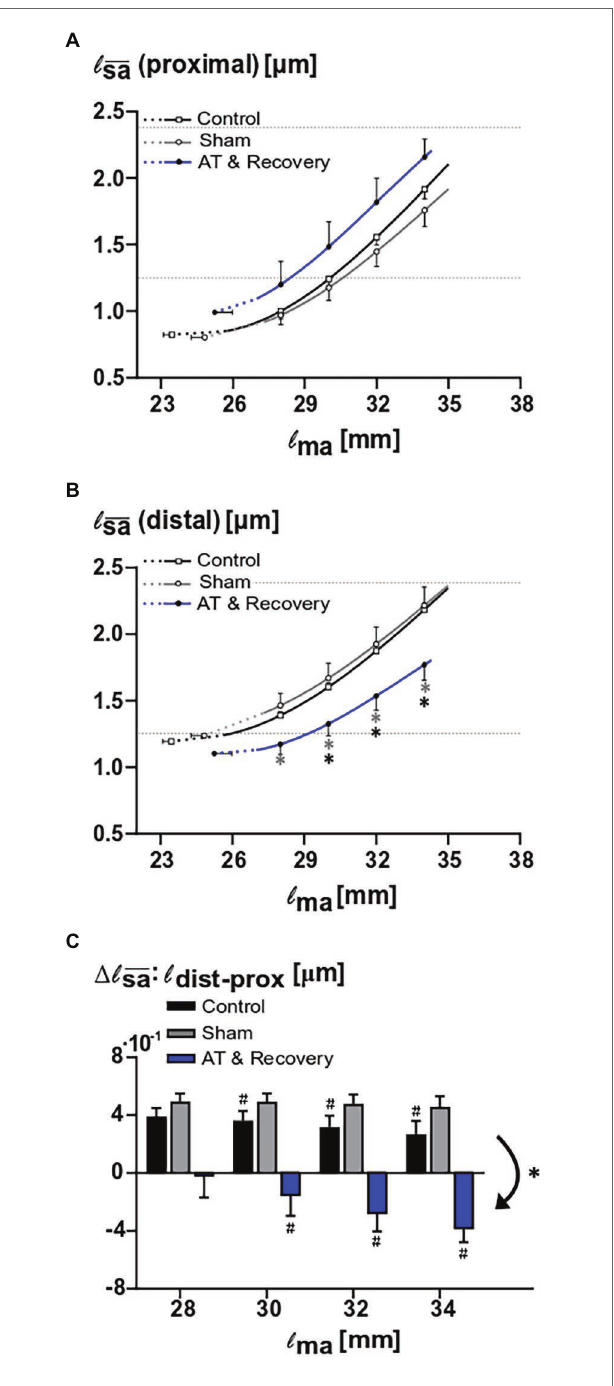
FIGURE 5 | Effects of aponeurotomy plus recovery on fiber mean sarcomere lengths. (A) Proximal muscle fiber mean sarcomere length (l sa proximal) plotted as function of active muscle length. The aponeurotomy plus recovery had no significant effect on the active sarcomere lengths ( p < 0.126). This indicates that the contribution of the proximal muscle fibers to muscle active force was not affected by the intervention. (B) Distal muscle fiber mean sarcomere length (l distal) as function of active muscle length. Differences sa between the aponeurotomy recovery and control group and sham group